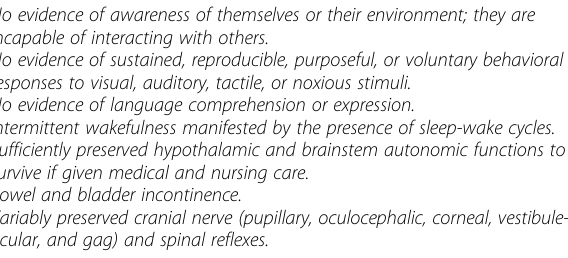
Table 2 Diagnosis of vegetative state [1, 16] No evidence of awareness of themselves or their environment; they are incapable of interacting with others. No evidence of sustained, reproducible, purposeful, or voluntary behavioral responses to visual, auditory, tactile, or noxious stimuli. No evidence of language comprehension or expression. Intermittent wakefulness manifested by the presence of sleep-wake cycles. Sufficiently preserved hypothalamic and brainstem autonomic functions to survive if given medical and nursing care. Bowel and bladder incontinence. Variably preserved cranial nerve (pupillary, oculocephalic, corneal, vestibule- ocular, and gag) and spinal